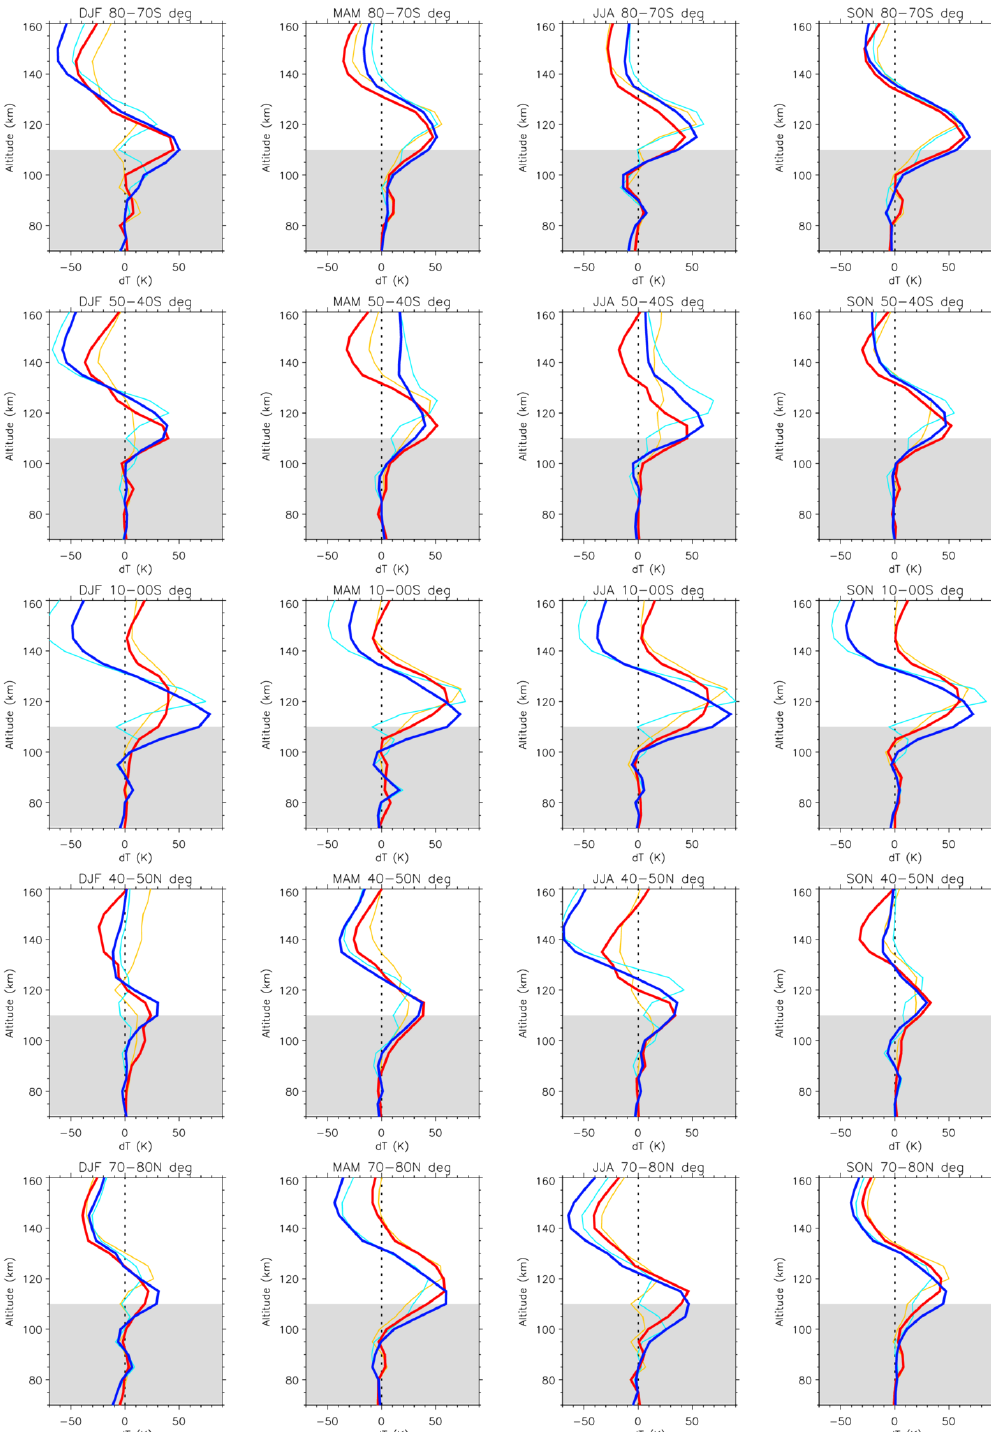
Figure 20. Seasonal mean temperature differences between MIPAS and NLRMSIS2.0 temperatures for various latitude bands. Left to right: DJF, MAM, JJA, SON. MIPAS version 8–NRLMSIS2.0 is shown for morning (red) and afternoon (dark blue) observations. MIPAS version 5–NRLMSIS2.0 is shown for morning (orange) and afternoon (light blue) for comparison. The grey-shaded areas indicate the vertical range where MIPAS temperatures are from the 15µm